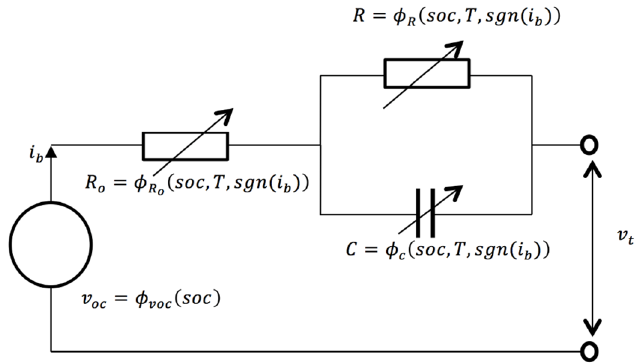
Figure 1. Real-time equivalent circuit model (ECM)